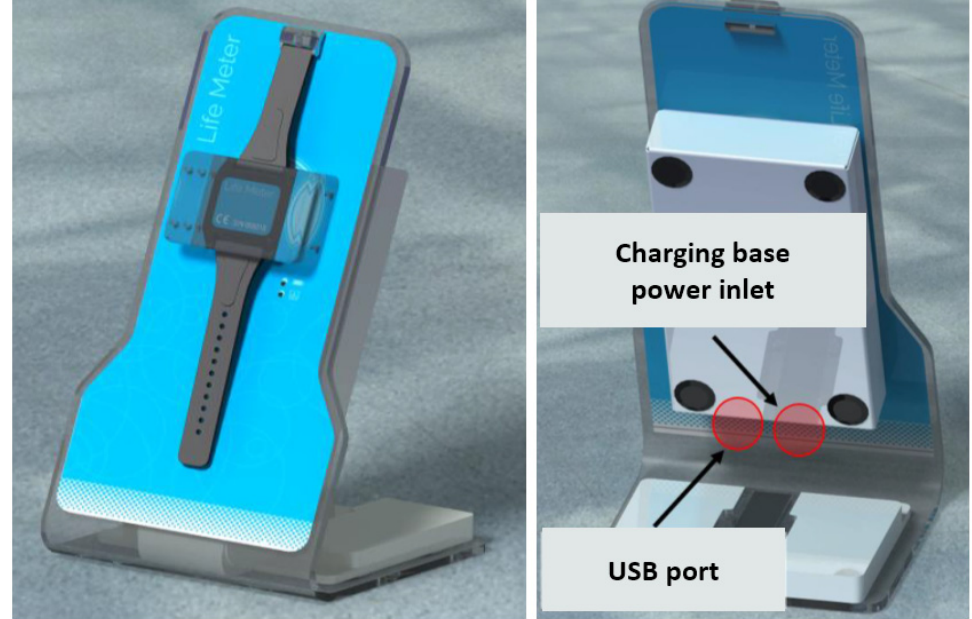
Figure 2. Front ( left ) and rear ( right ) view of the BrOxy M device charging base. The charging base is used to carry out wireless charging of the Li-Ion battery integrated into the BrOxy M device. Moreover, the charging base connects via USB to the PC and via Wi-Fi to the BrOxy M device, acting as a bridge for downloading the recorded signals and to manage the device during all operational phases (memory cancellation, device status check, device calibration, fixing on the subject, and start or stop recording).